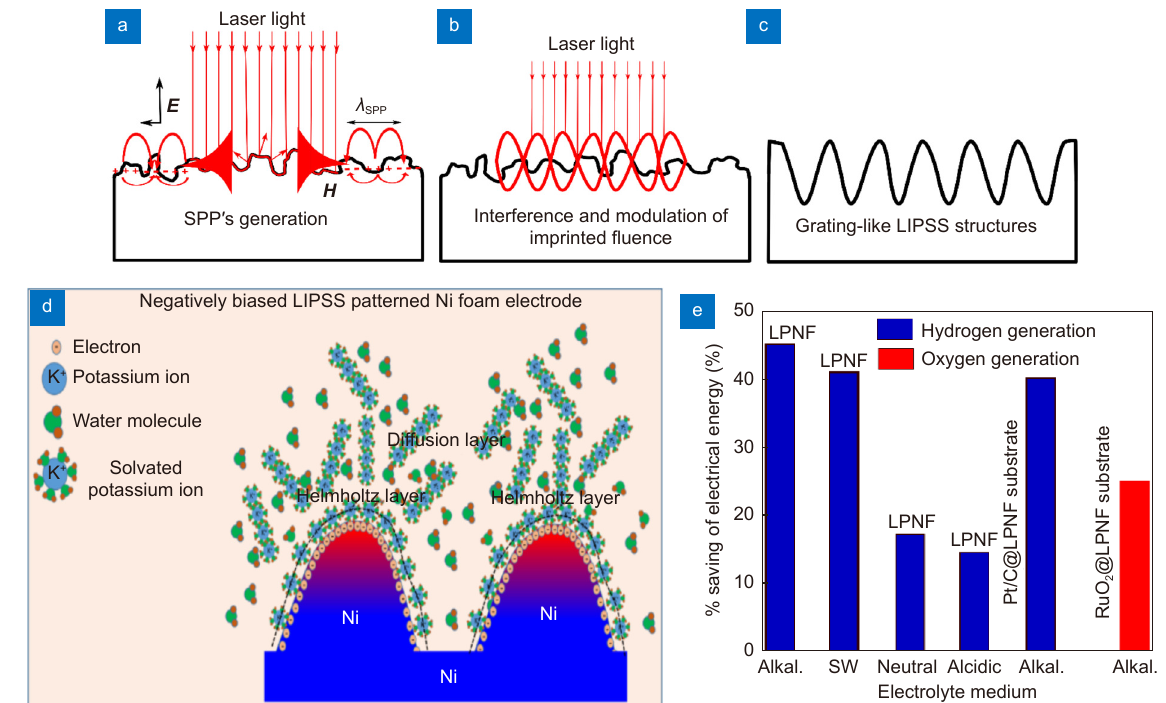
Fig. 1 | Schematic illustrations of LIPSS formation, localized electric field induced enhancement in reagent concentration and experi- mental results of decrease in electrical energy . Schematic of LIPSS formation ( a ) surface plasmon polariton (SPP) generation and propaga- tion parallel to the surface, ( b ) interference between the incident light wave and SPP wave to modulate the light intensity, and ( c ) imprinting of the interference pattern through selective ablation of material. ( d ) Schematic of the Gouy-Chapman-Stern electrical double layer model to represent mechanism behind localized electric field induced enhancement in the reagent concentration, and ( e ) experimental results showing percentage decrease in the required electrical potential to generate 10 mA/cm 2 of current density using the LIPSS patterned electrodes in different electro- lytes (i.e., alkaline, seawater (SW) neutral, acidic